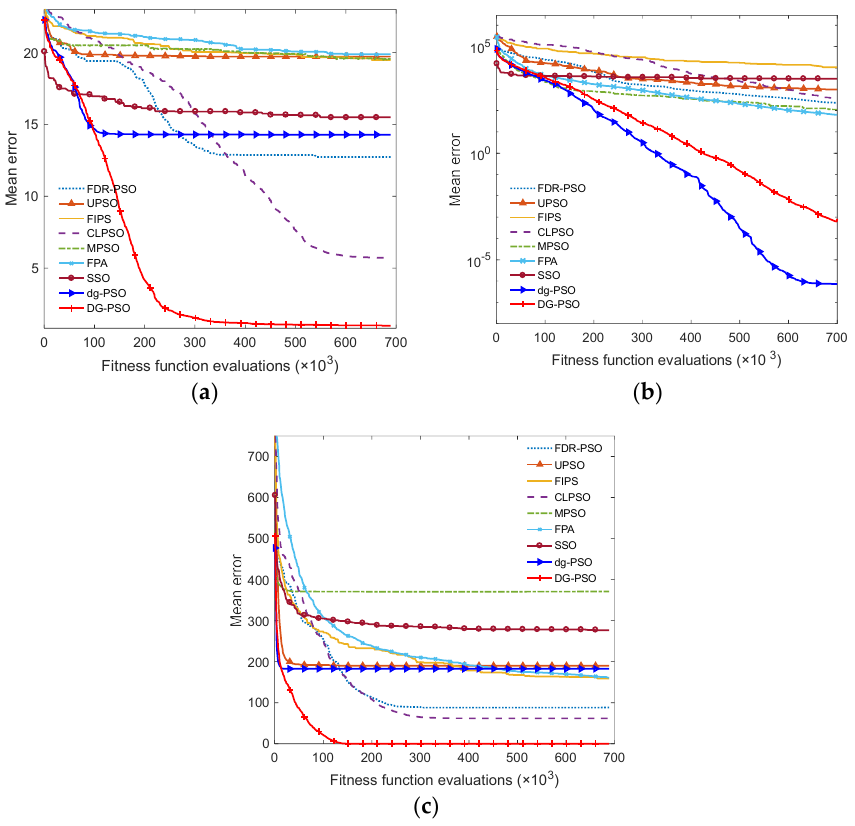
Figure 4. Convergence performance. ( a ) F8, multimodal; ( b ) F10, rotated unimodal; ( c ) F14, shifted multimodal.